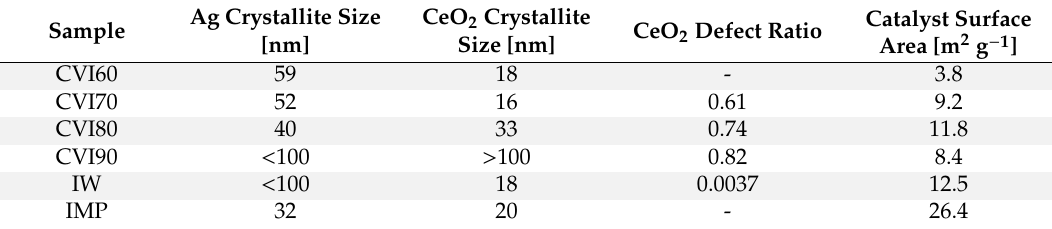
Table 1. Catalyst characterization data. The crystallite size calculated from XRD, the CeO 2 defect ratio obtained from Raman spectroscopy, and the catalyst surface area obtained from BET.